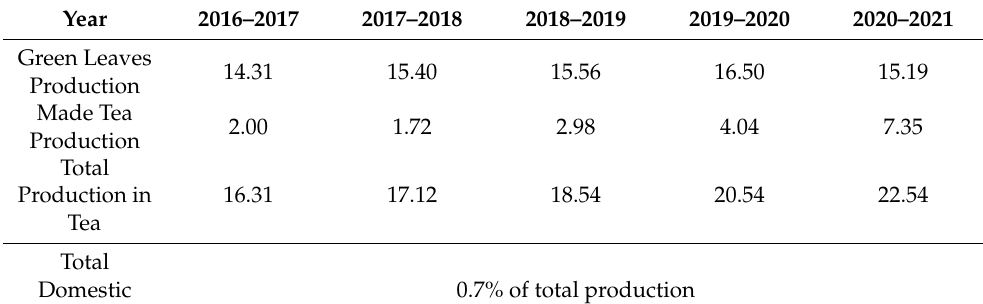
Table 3. The position of production of tea in Tripura and its domestic consumption during the last 5 years under TTDC Ltd. Amount in lacs kgs.